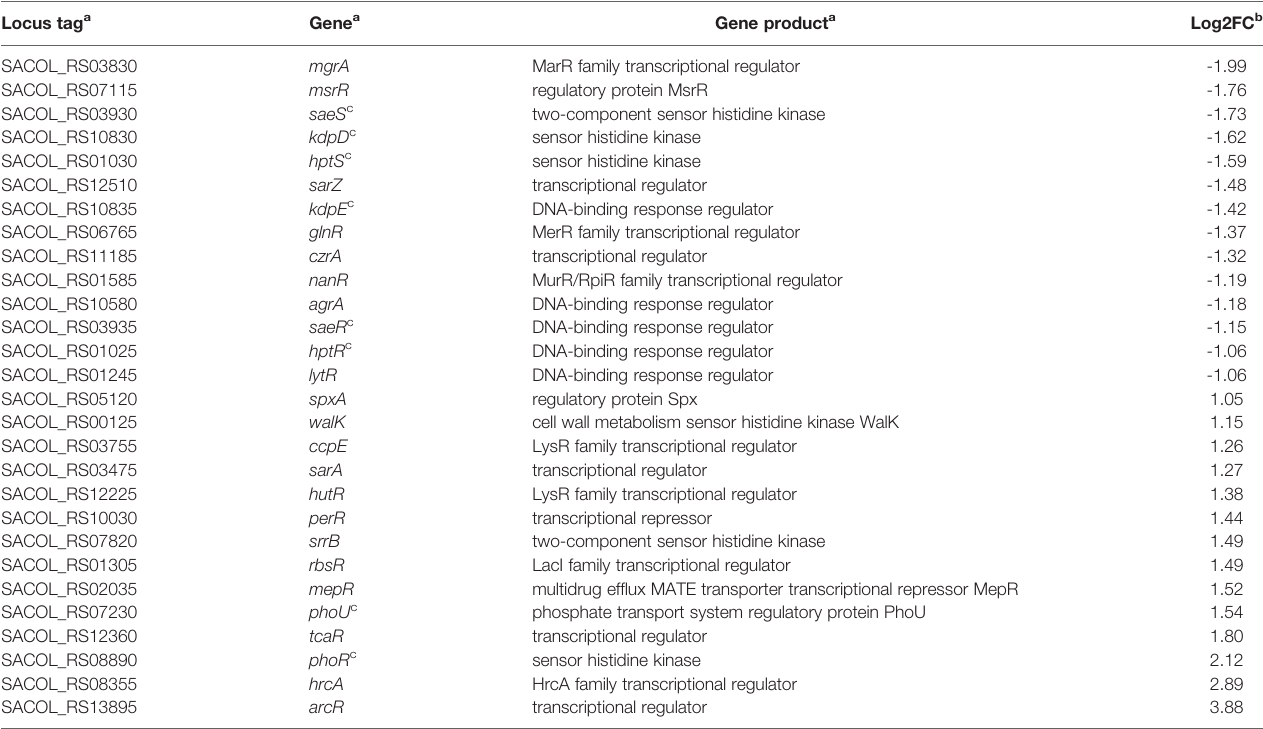
TABLE 1 | Differential expression of genes encoding transduction systems in S. aureus . Locus tag